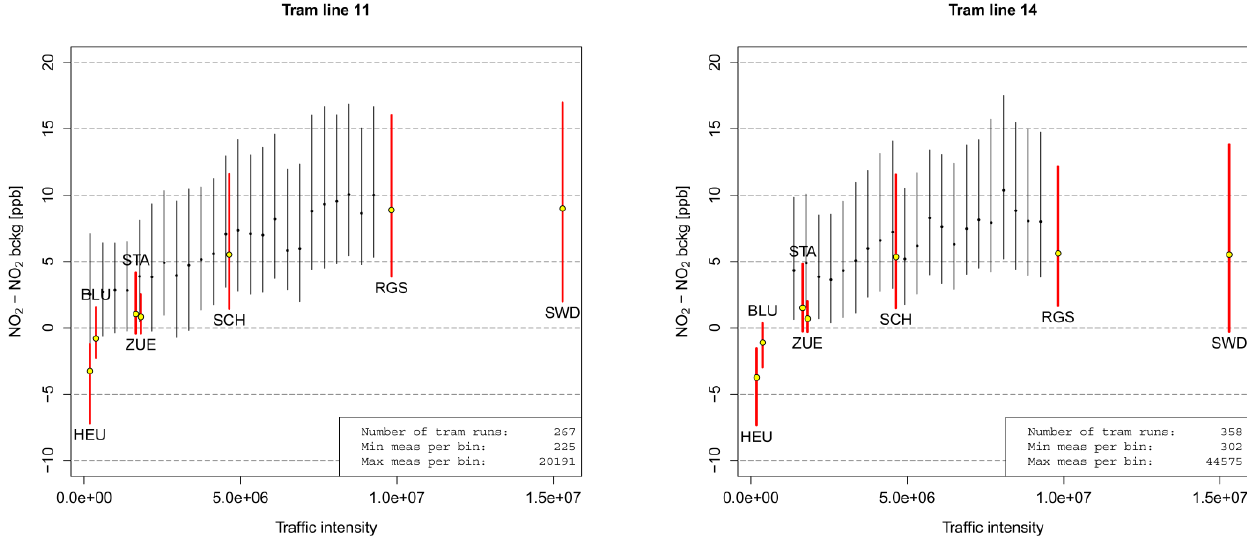
Figure 12. Local emission signal (i.e., difference between measured- and the background NO 2 concentration) related to the traffic intensity. The values from the tram instrument (QCLAS) are aggregated by equally spaced bins and depicted in black. The values from the AQM sites (CLD) are shown in red. The lines span the 25 to the 75% quantiles, the dots represent the 50%